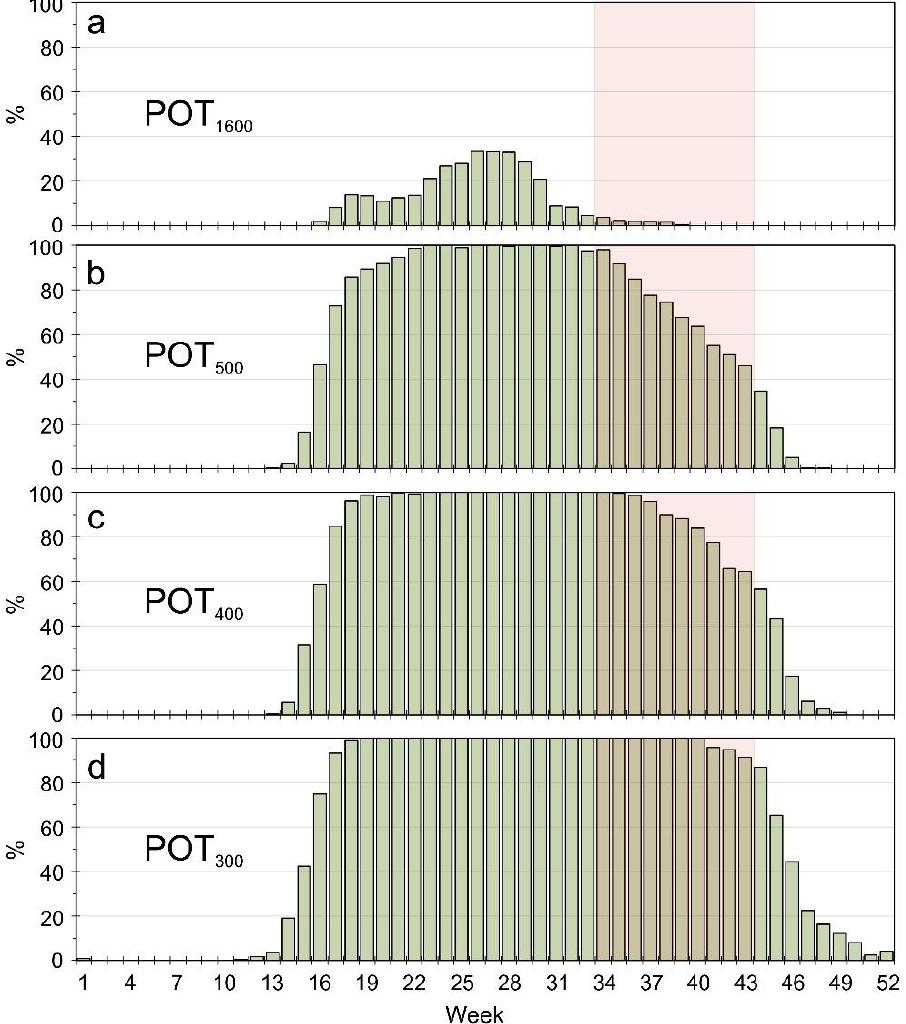
Figure 5. Observed historical mean percentage over threshold (POT) in a given week when daily flows were greater than navigation thresholds ( a ) 1600 m 3 s −1 (POT 1600 ), ( b ) 500 m 3 s −1 (POT 500 ), ( c ) 400 m 3 s −1 (POT 400 ), and ( d ) 300 m 3 s −1 (POT 300 ) for the period spanning 1958 to 2020. The fall navigability period is highlighted in transparent red.